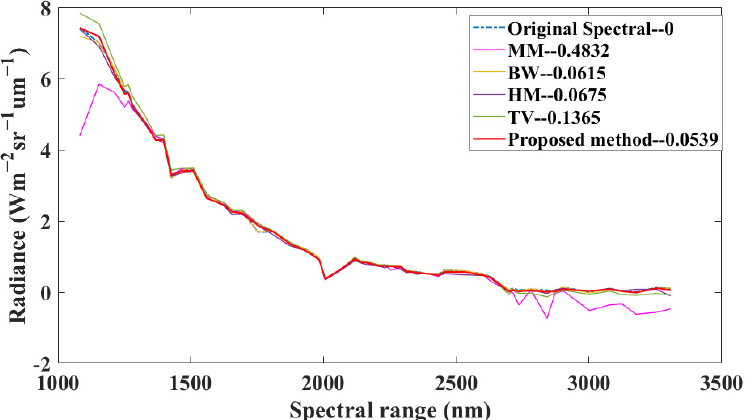
Figure 14. Spectral irradiance trends in the original image and in one area in the image after pro ‐ cessing via different methods. processing via different methods.